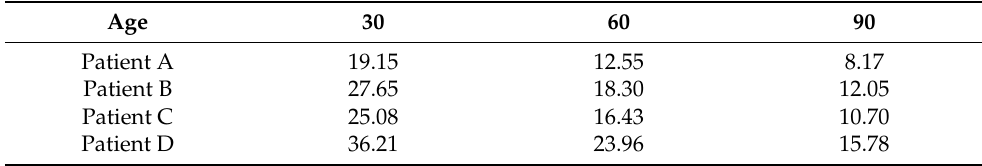
Table 8. Median time for some